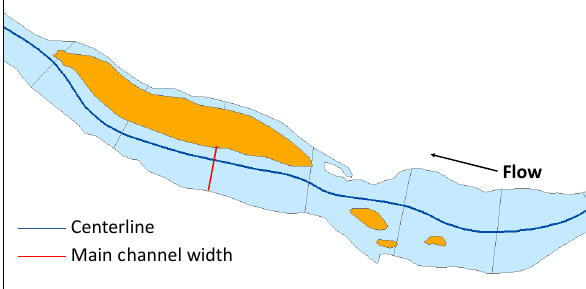
Figure 2. Spatial representation of the channel centerline, channel width and channel 250m sections in presence of islands (from the FRAZIL